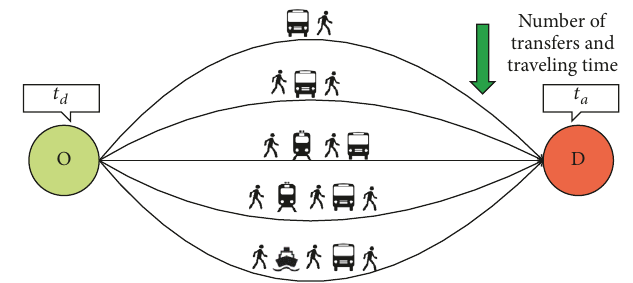
Figure 1: The scope of the